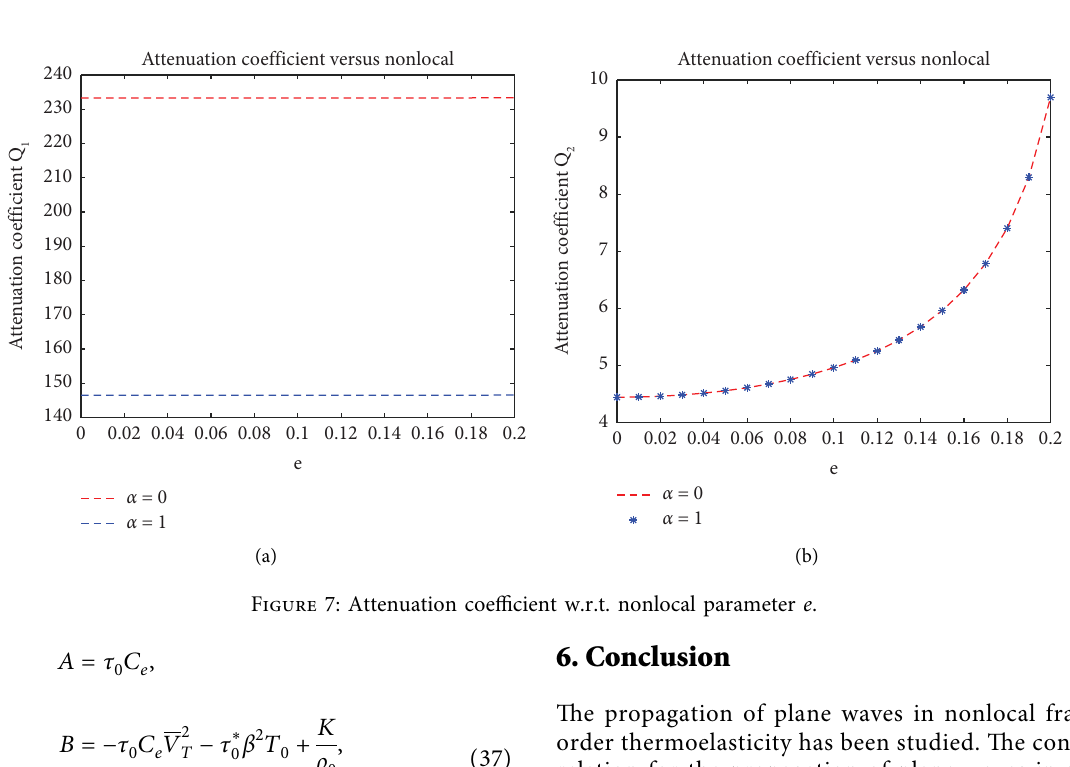
Figure 6: Specifc loss w.r.t. nonlocal parameter e .